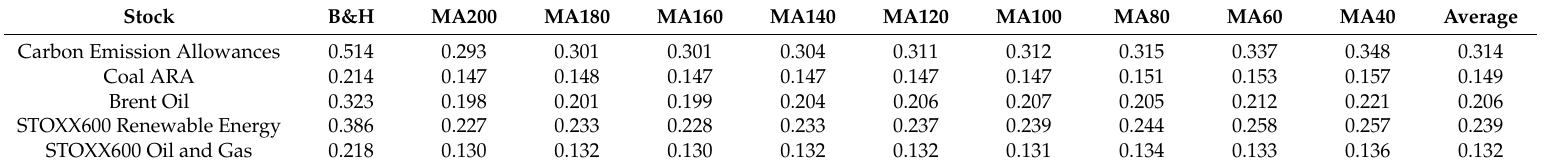
Table A8. Annualized daily volatility of MA40–MA200, average annualized volatility.